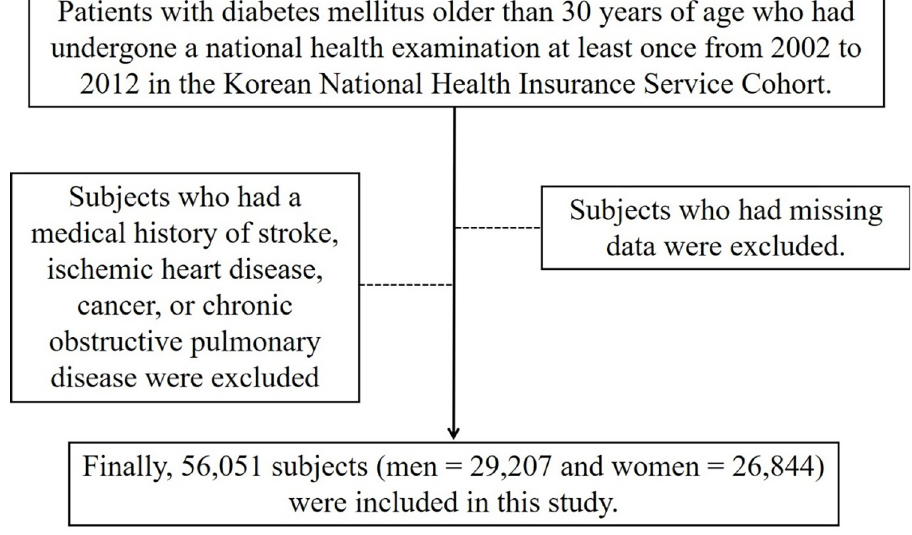
Fig 1. Flow chart of participant